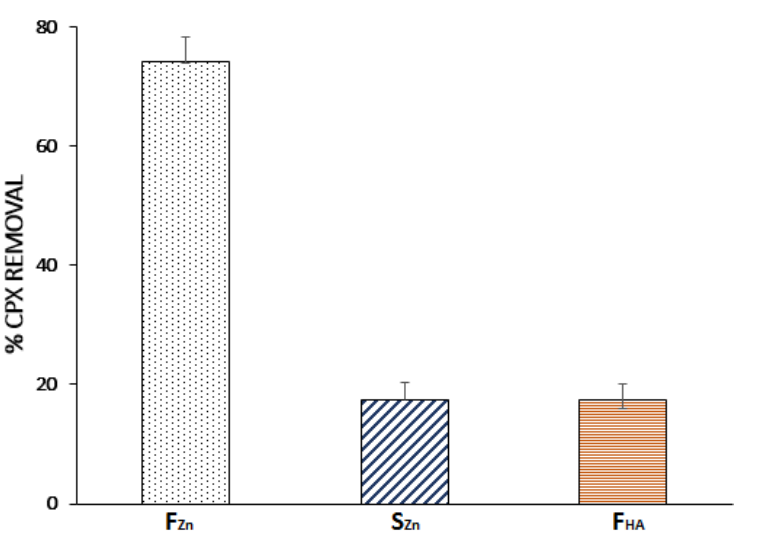
Figure 1. Performance of each adsorbent material for cephalexin (CPX) removal (adsorption condi- Table 1. Physical and chemical surface properties. PZC, point of zero charge.